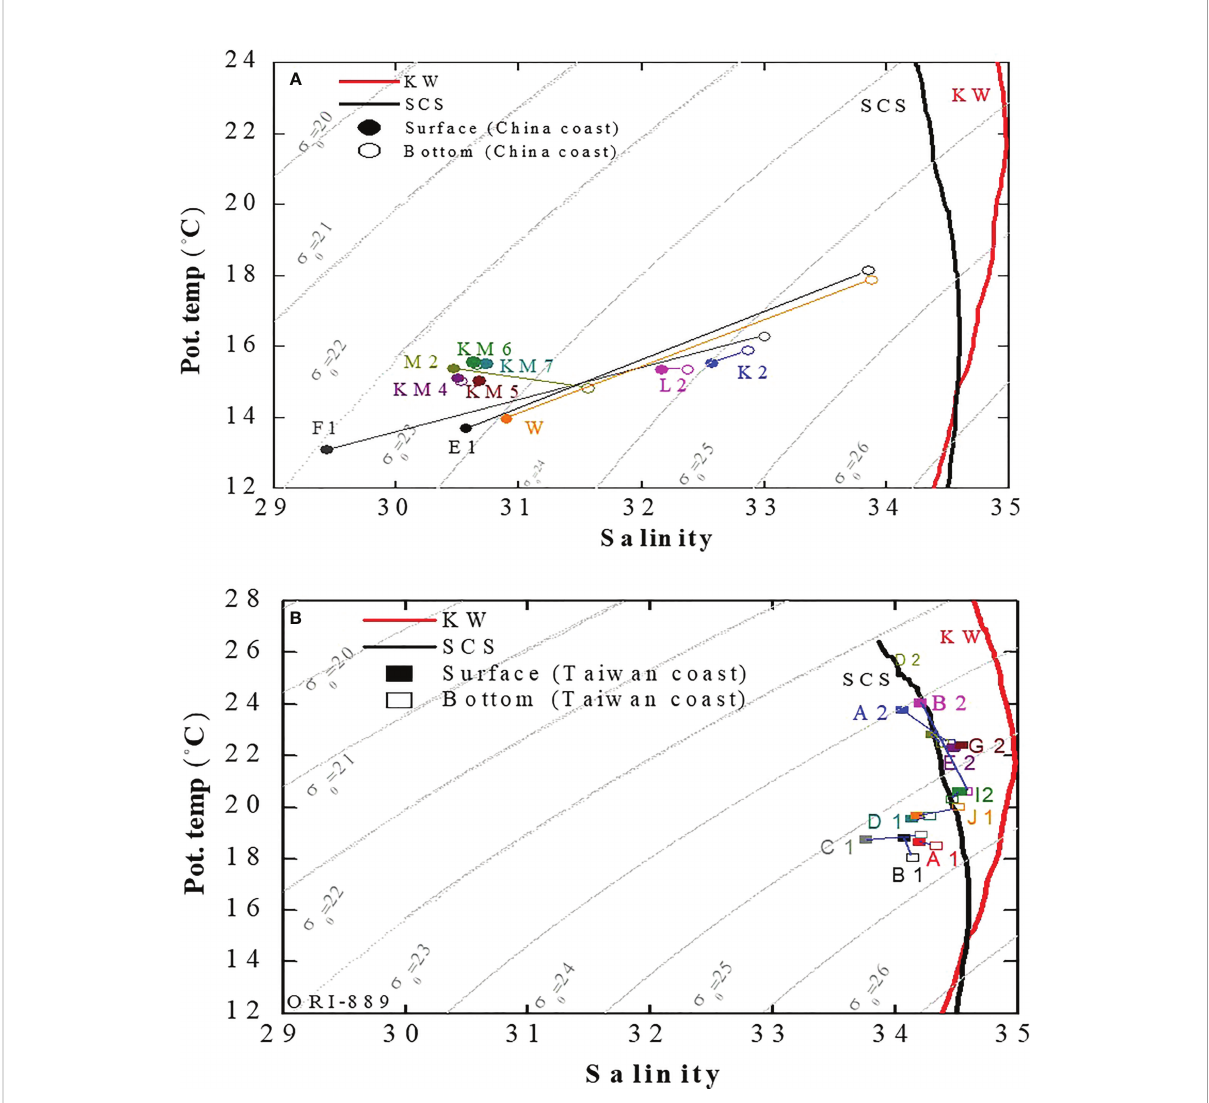
FIGURE 3 Schematic plots of T − S relationships for surface and bottom waters collected from stations located in the western TS (on the coast of China) (A) and the central and eastern TS (on the coast of Taiwan, B ) in winter. The surface and bottom waters at each station are connected by dotted lines. The “ KW ” and “ SCS ” curves represent the typical T − S features of the KW and SCSW, respectively. The KW and SCSW represent typical waters collected from the western Philippine Sea and SCS central basin,